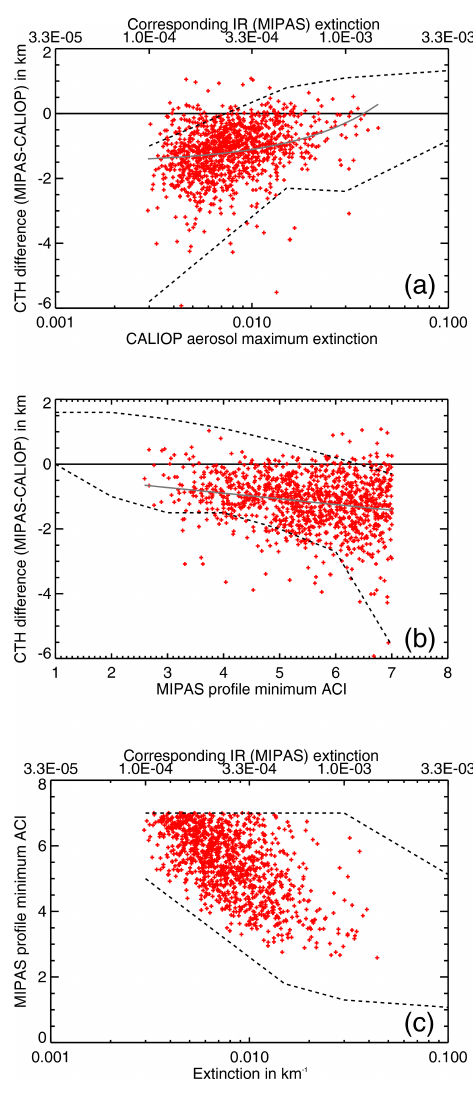
Figure 9. Cloud top height differences between MIPAS and CALIOP Nabro aerosol measurements (using a CALIOP extinc- tion threshold of 3 × 10 − 3 km − 1 ), as a function of (a) CALIOP aerosol layer maximum extinction, and (b) MIPAS minimum ACI. (c) shows the diagnostic relation between CALIOP maximum ex- tinction and MIPAS minimum ACI. The black dashed lines indicate the ranges expected from the simulations (see Fig.